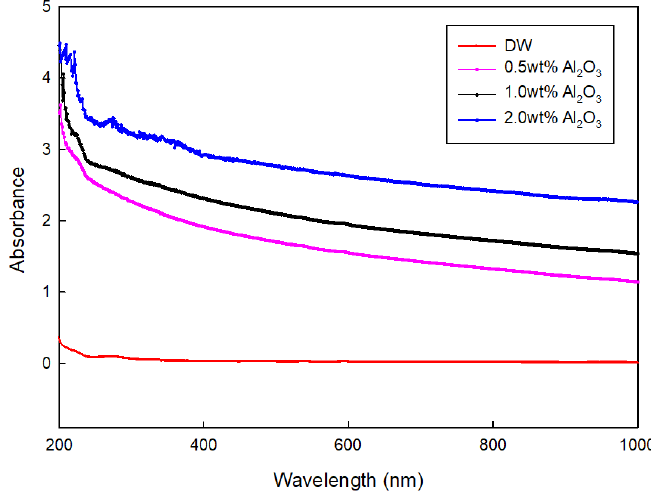
Figure 6. Absorbance of a base liquid (DW) and the nanofluids with three different alumina concen- trations. Reprinted from ref. [5].